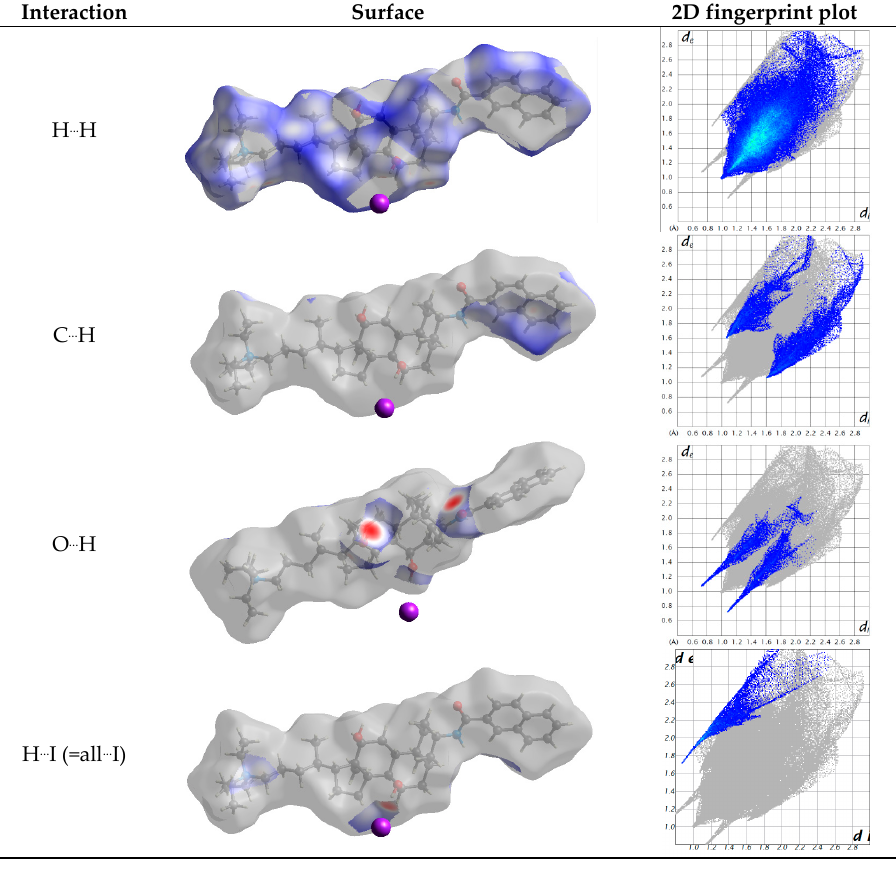
Figure 4. The contributions to the Hirshfeld surface area for the various close intermolecular contacts in 1 . d norm surface of 1 , highlighting the indicated intermolecular contacts, and corresponding 2D fingerprint plots. d e and d i in